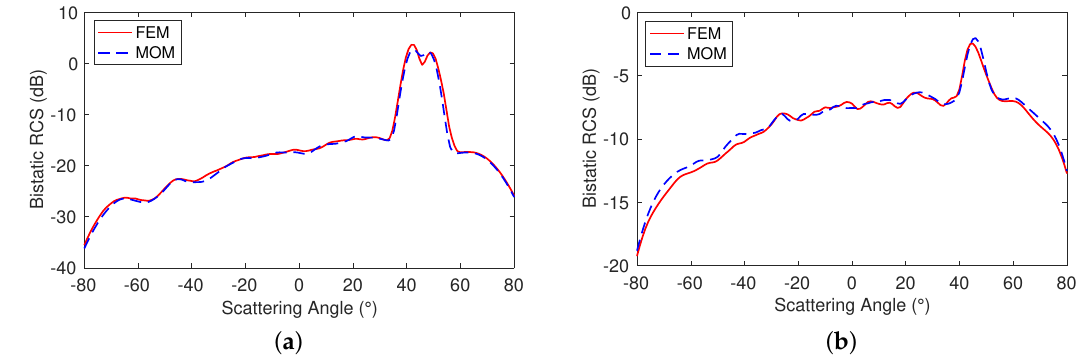
Figure 4. Bistatic RCS for a two-layer structure with ( a ) slightly rough surfaces and ( b ) moderately rough surfaces simulated by the FEM and method of moment (MoM) at C-band. The incidence angle was 45 ◦ and the polarization was HH.